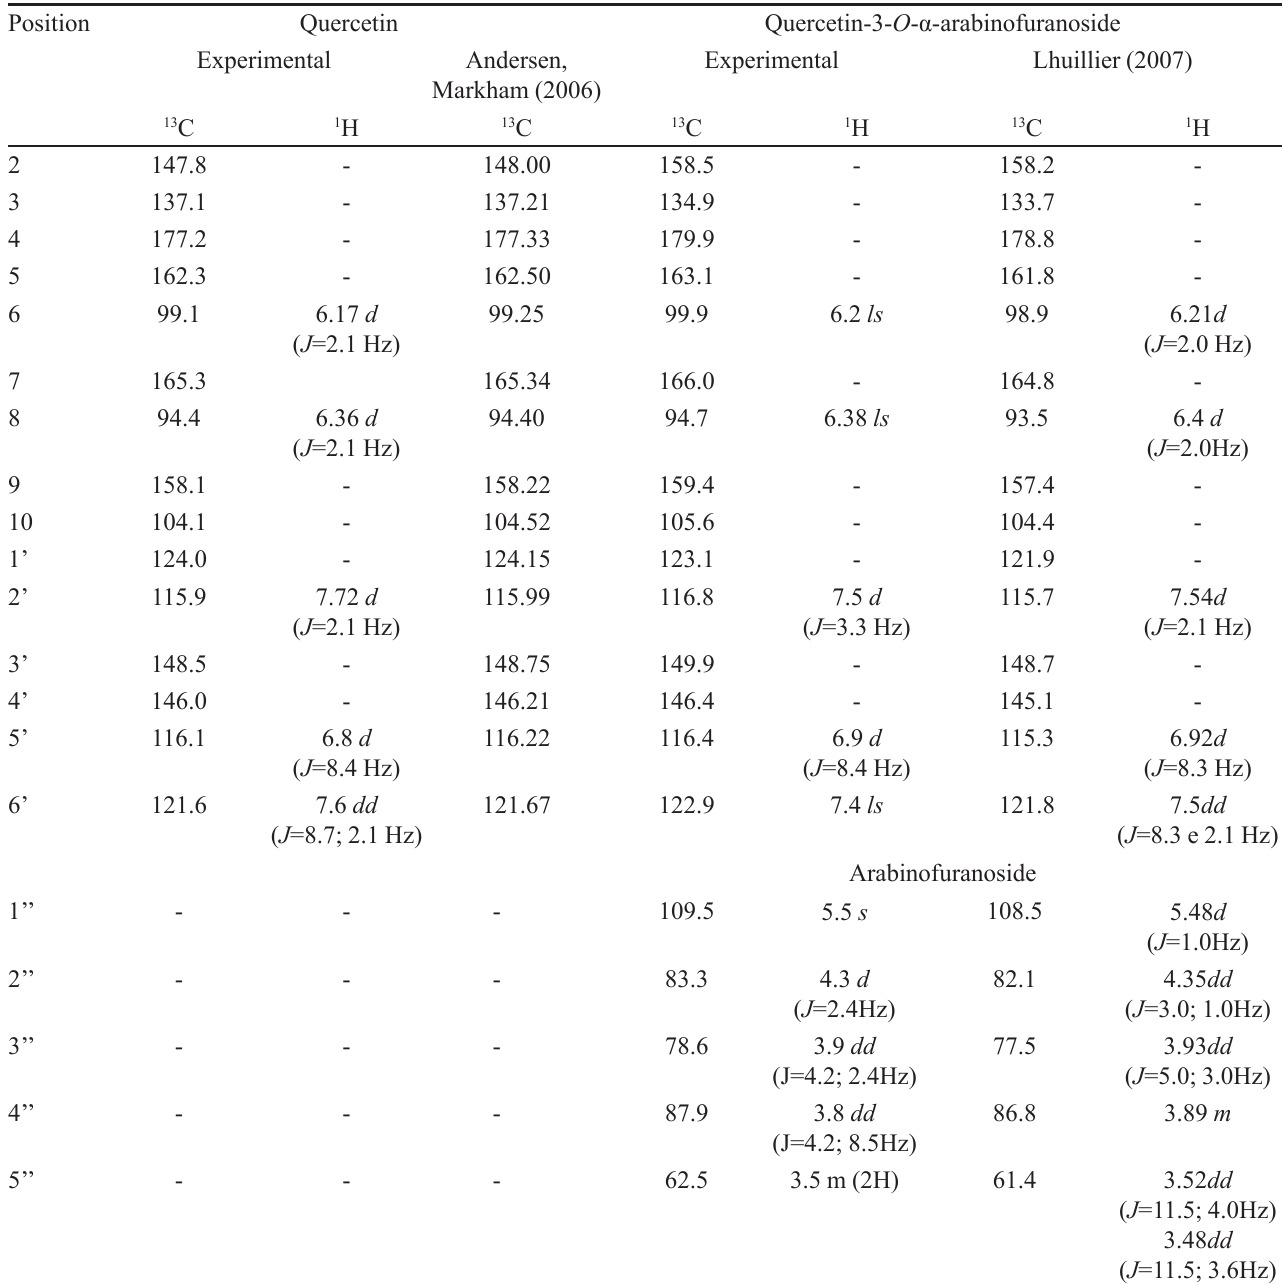
TABLE II - Compounds 2 and 3 NMR (ppm) experimental data compared against literature data Position Quercetin Quercetin-3- O -α-arabinofuranoside Experimental Andersen, Markham